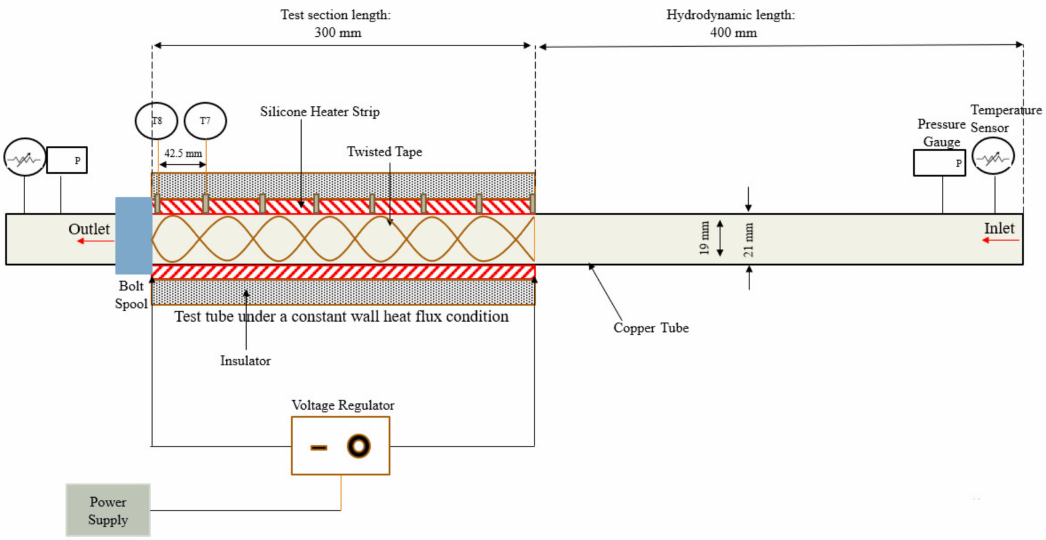
Figure 10. Schematic diagram of the test